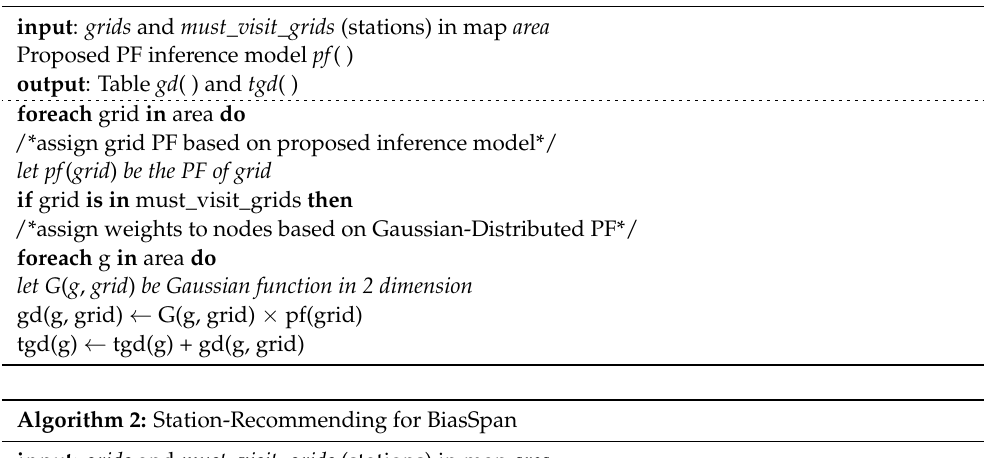
Algorithm 1: Grid-Preprocessing for BiasSpan